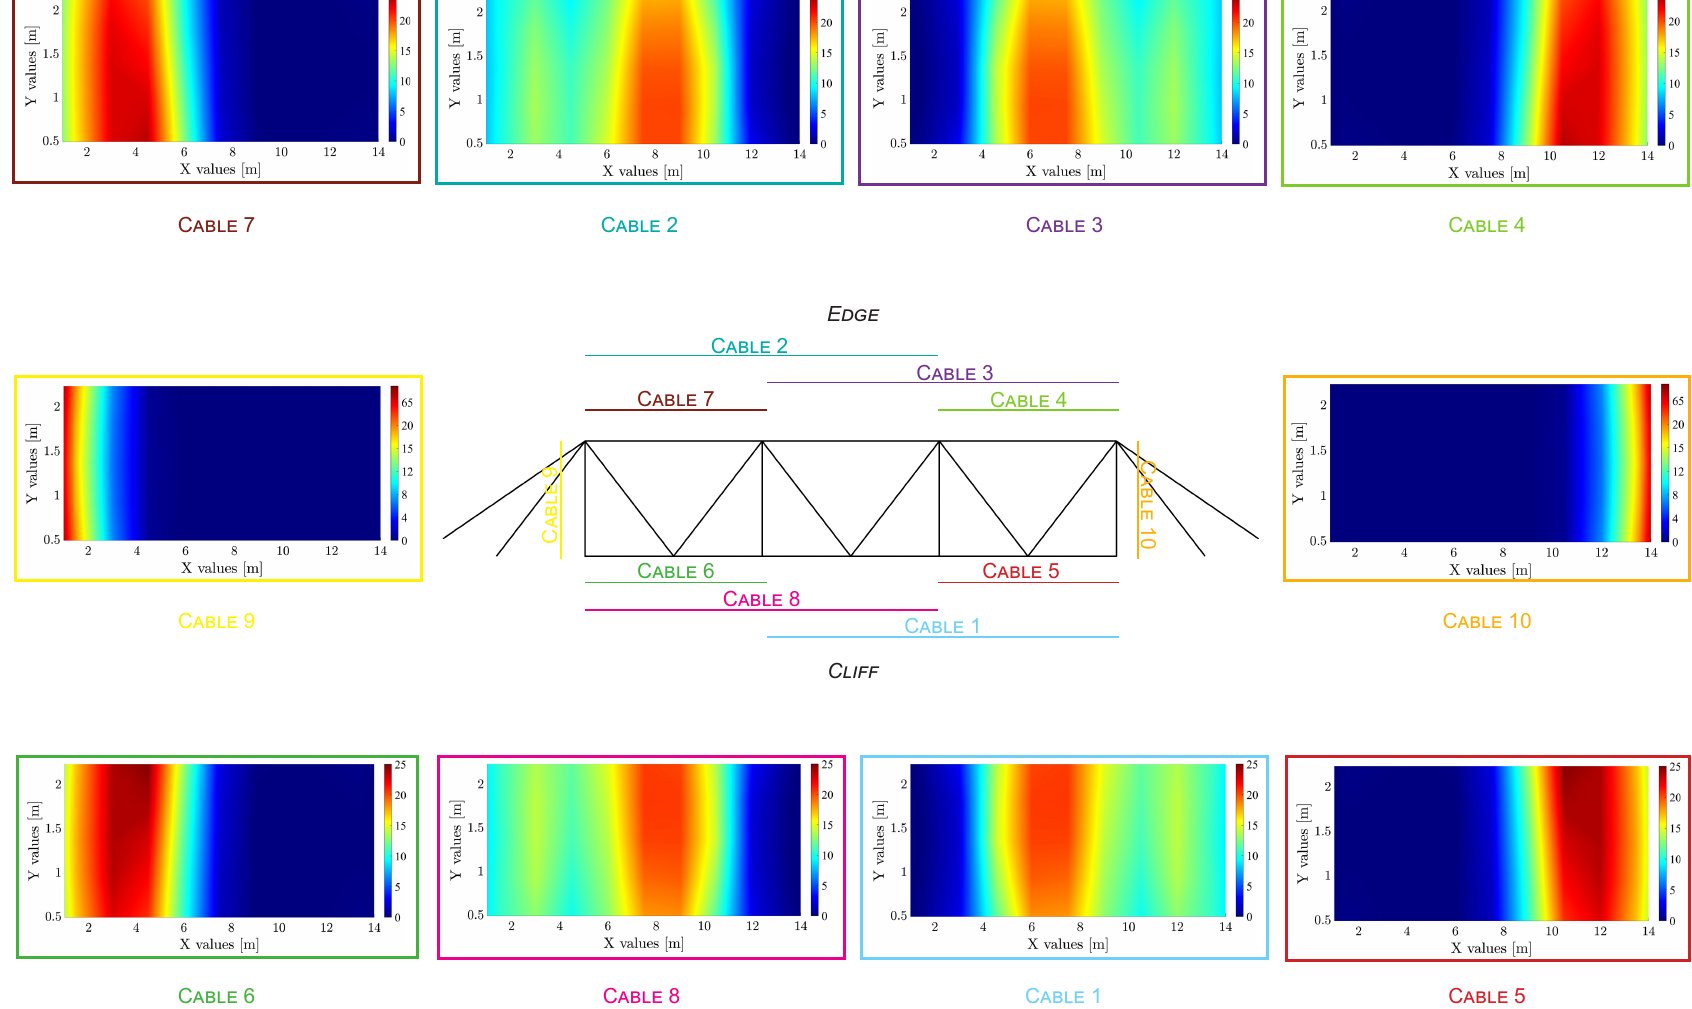
Figure 16. Percentage of the energy dissipated plastically in each cable on the initial mechanical energy, supposing a constant threshold of